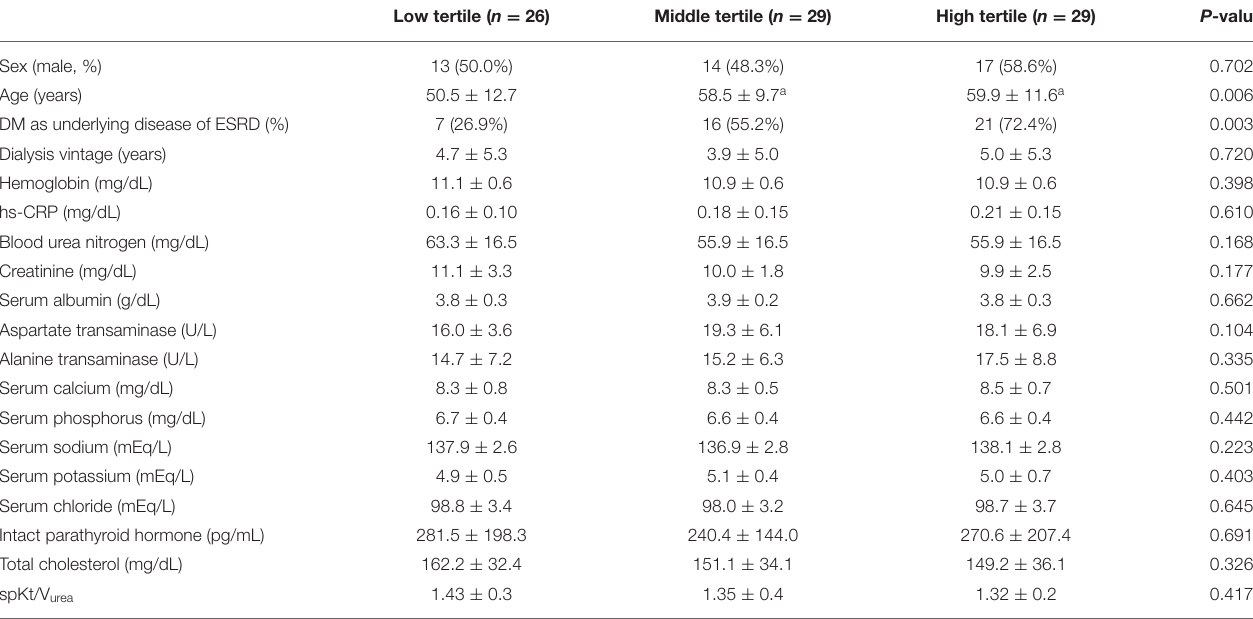
TABLE 1 | Participants’ clinical